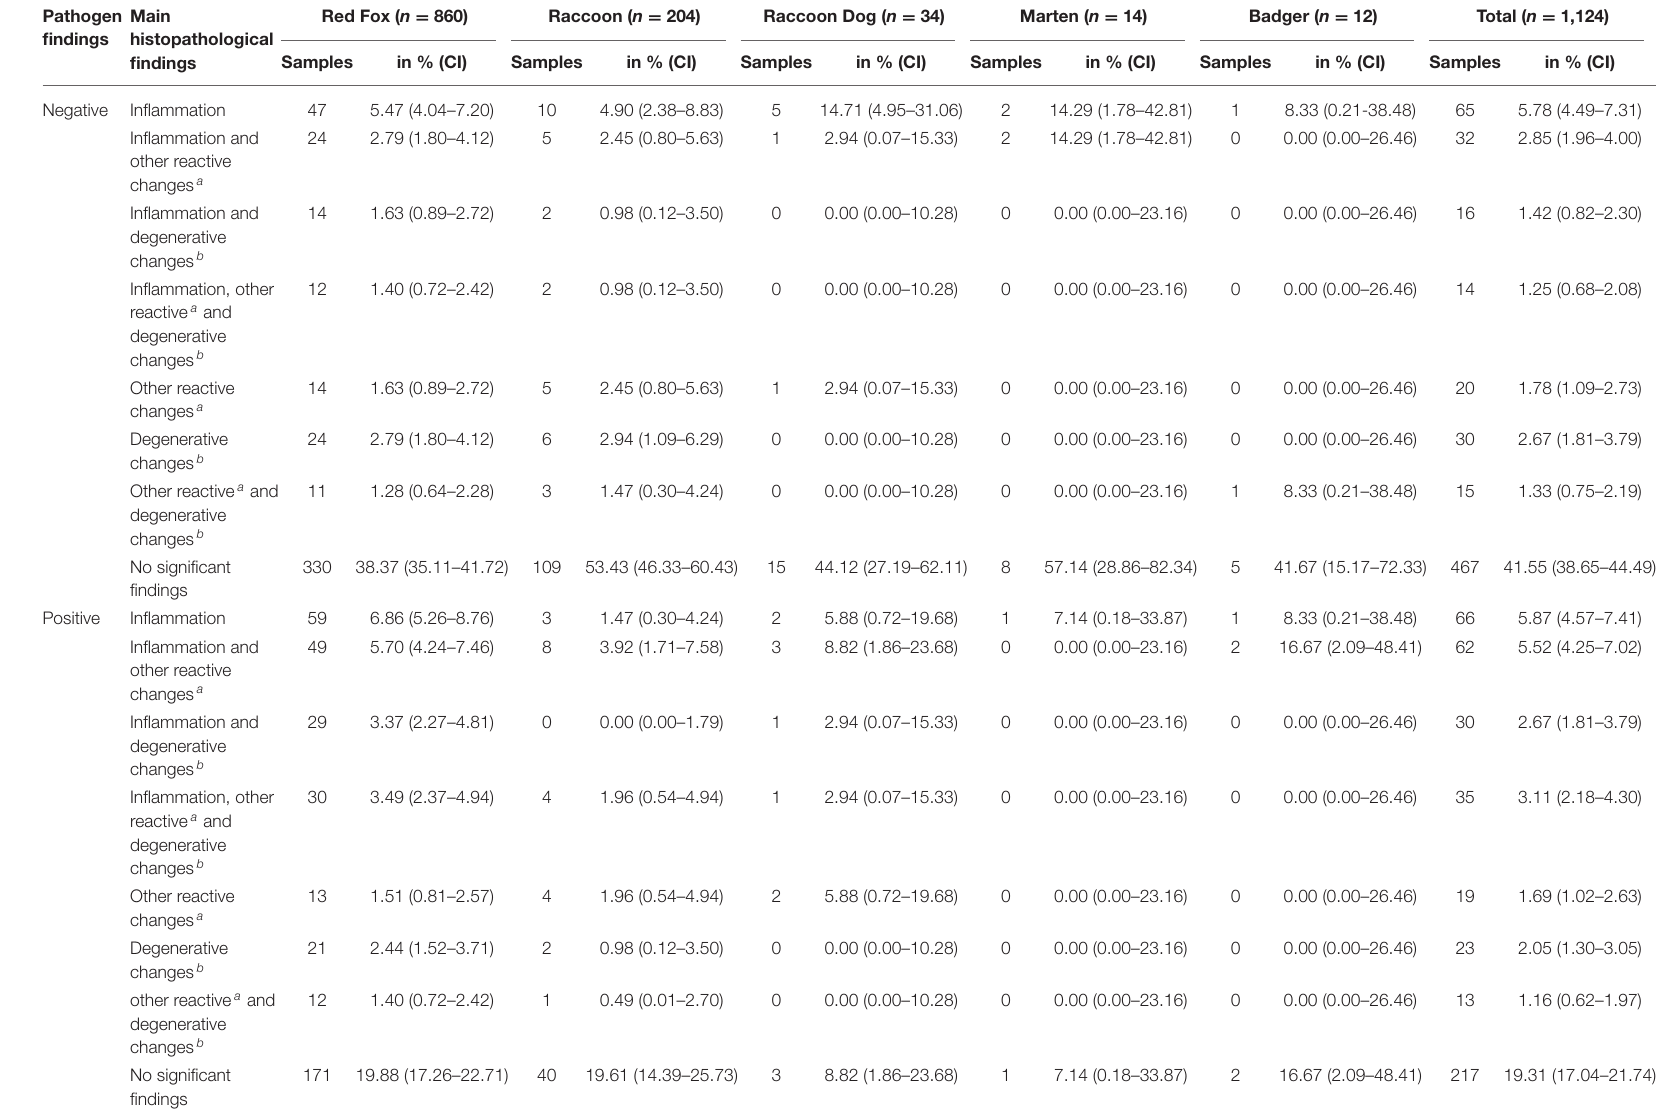
TABLE 5 | Pathogen discovery correlated with main histopathological findings in each animal species. Pathogen Main findings